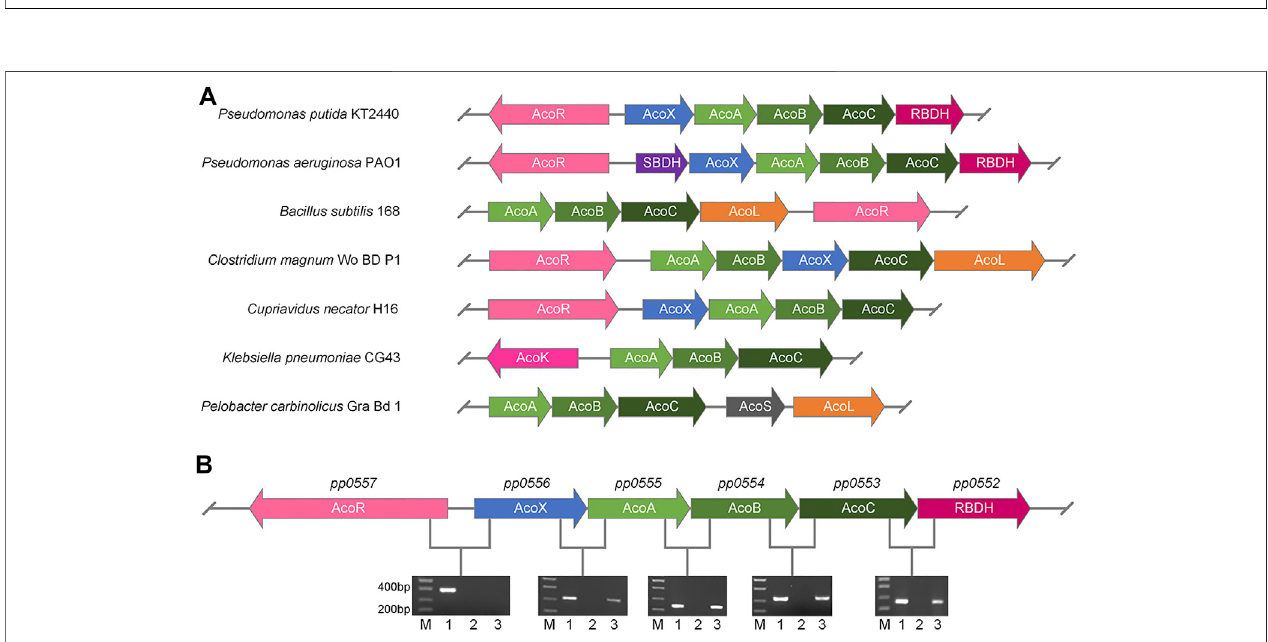
FIGURE 2 | Identi fi cation of R , R -BDH in 2,3-BDO utilization operon of P. putida KT2440. (A) Gene clusters arrangement of genes for 2,3-BDO and AC catabolism in different species. (B) Co-transcription analysis of genes in 2,3-BDO utilization operon of P. putida KT2440 by RT-PCR (lane 3). The genomic DNA (lane 1) and RNA (lane 2) of P. putida KT2440 were used as positive and negative control, respectively. P. putida KT2440 were cultured in MSM supplemented with 2 g L − 1 mixed 2,3- BDO as the sole carbon source.